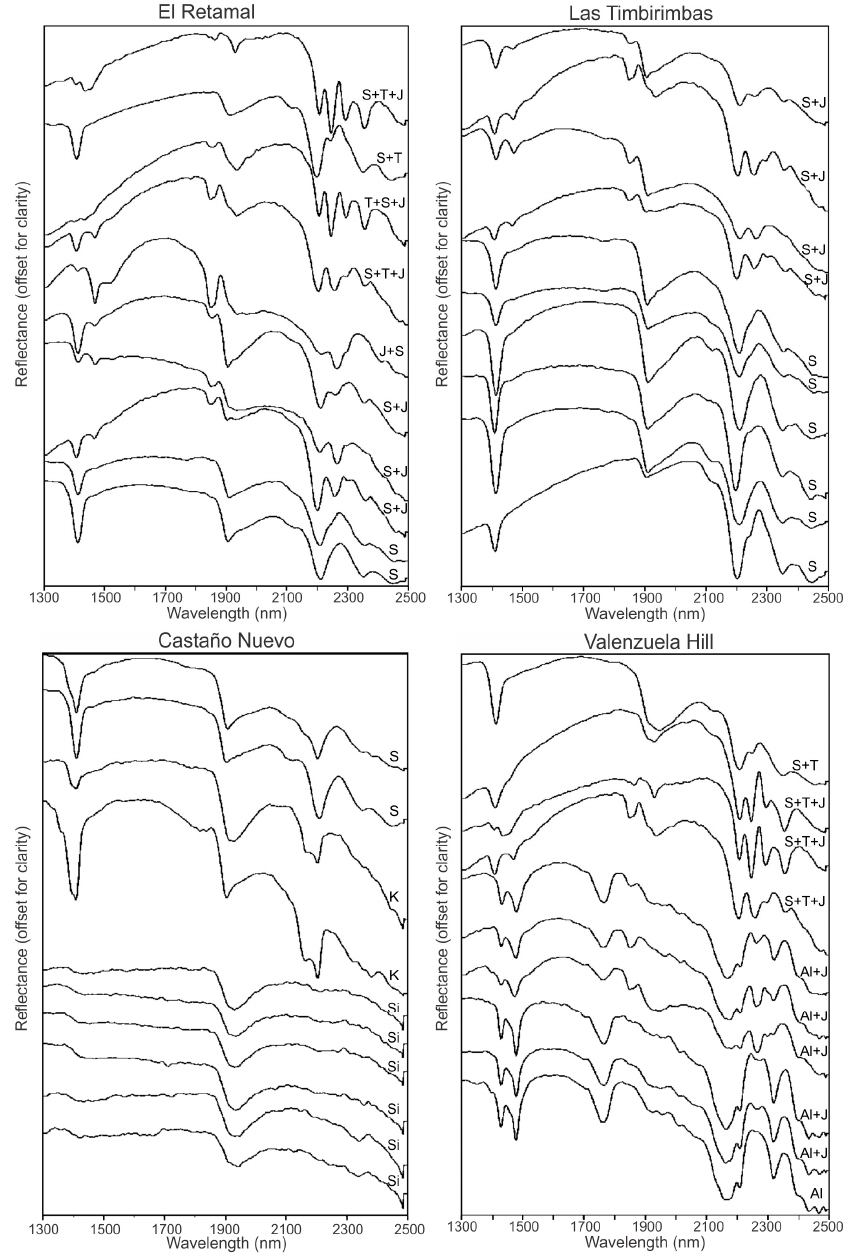
Figure 16. Most common PIMA spectra obtained from rock samples from El Retamal, Las Timbirimbas, Castaño Nuevo and Valenzuela Hill [20]. For the location of each area see the geologic map in Figure 3 and/or the ASTER products in this study. For further information regarding field localities and sample information see Delendatti (2003) [20]. The abbreviations for single minerals and mineral assemblages on each spectrum correspond to: Illite or sericite (S), tourmaline (T), jarosite (J), kaolinite (K), silica (Si) and alunite (Al).